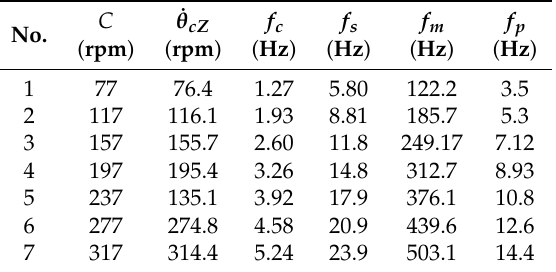
Table 3. Simulated rotational speed